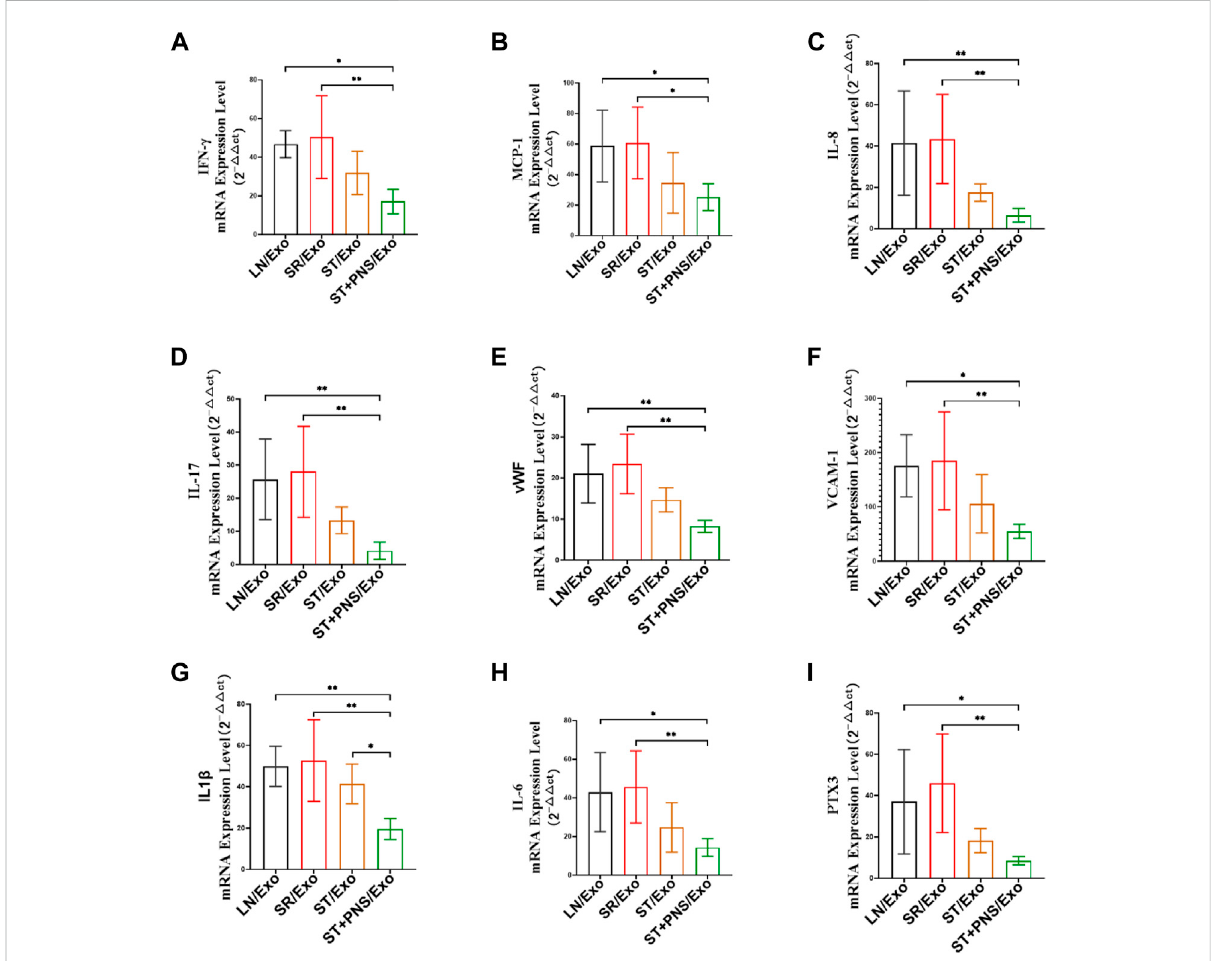
FIGURE 8 Renalcorticalin fl ammatoryfactormRNAexpressionwasdetectedbyqRT-PCR. (A – I) mRNAexpressionlevelsof IFN- γ ,MCP-1,IL-17,IL-8 , vWF, VCAM-1, IL-1 β , IL-6, and PTX3 . All data are expressed as the mean ± standard deviation from independent groups, *p < 0.05, **p <